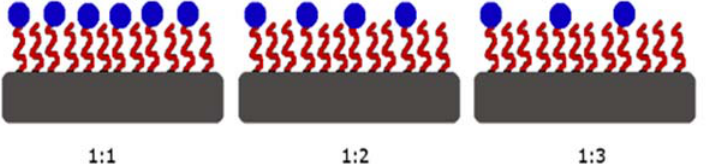
Figure 3. Two-dimensional schematic of the PEG-biotin:PEG ratios of 1:1, 1:2, and 1:3. The grey surface indicates the (100) silica-on-silicon wafer surfaces. The curved lines on the surface indicates the PEG coating, while the dark blue dots indicate the biotin molecules. Note that the amount of PEG-biotin in solution was kept constant, while the amount of PEG was